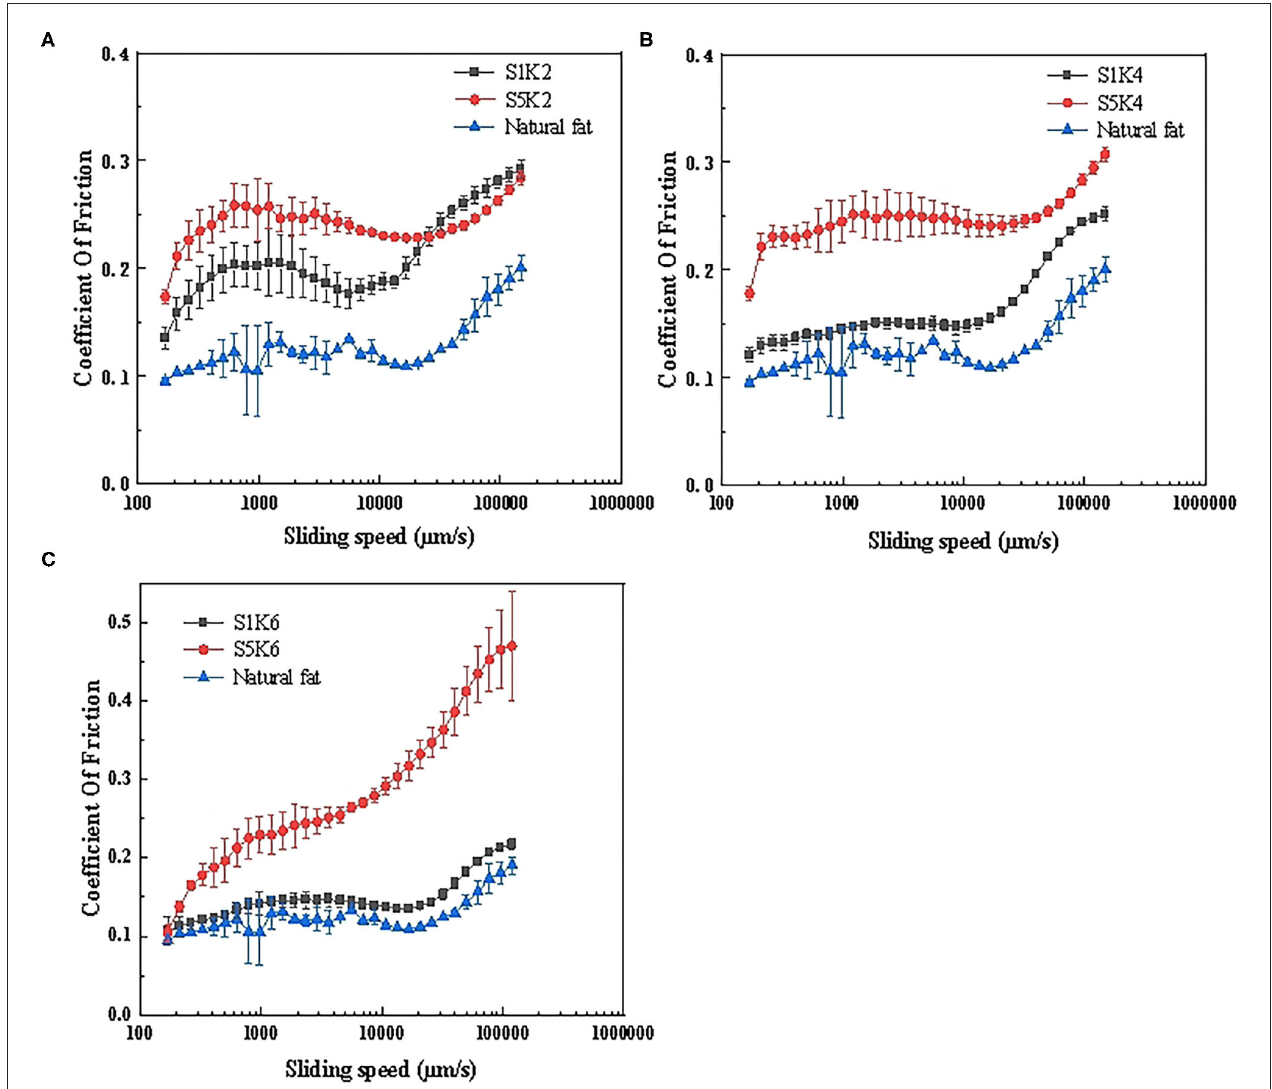
FIGURE 4 | Friction curves of samples with different protein content and konjac content. (A) S1K2, S5K2, pork fat (cook for 20min); (B) S1K4, S5K4, pork fat (cook for 20min); (C) S1K6, S5K6, pork fat (cook for 20min) ( n =